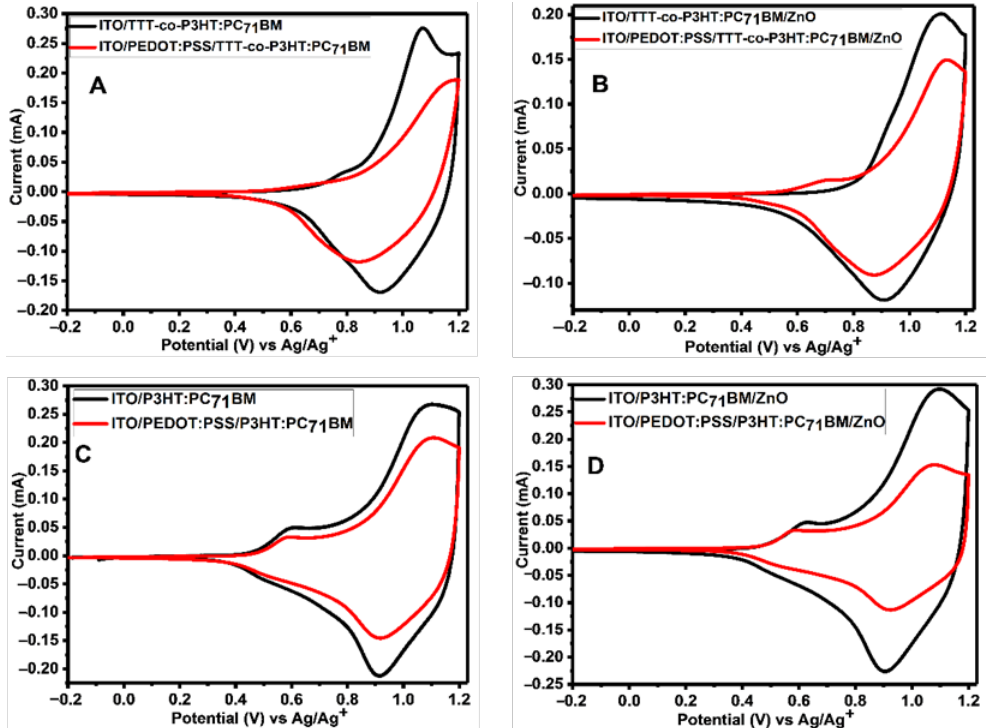
Figure Figure 7. CV of ( A ) TTT-co-P3HT:PC 71 BM, ( B ) PEDOT:PSS/TTT-co-P3HT:PC 71 BM, ( C ) P3HT:PC 71 BM and ( D ) PEDOT:PSS/P3HT:PC 71 BM thin films coated on ITO substrate with/without PEDOT:PSS